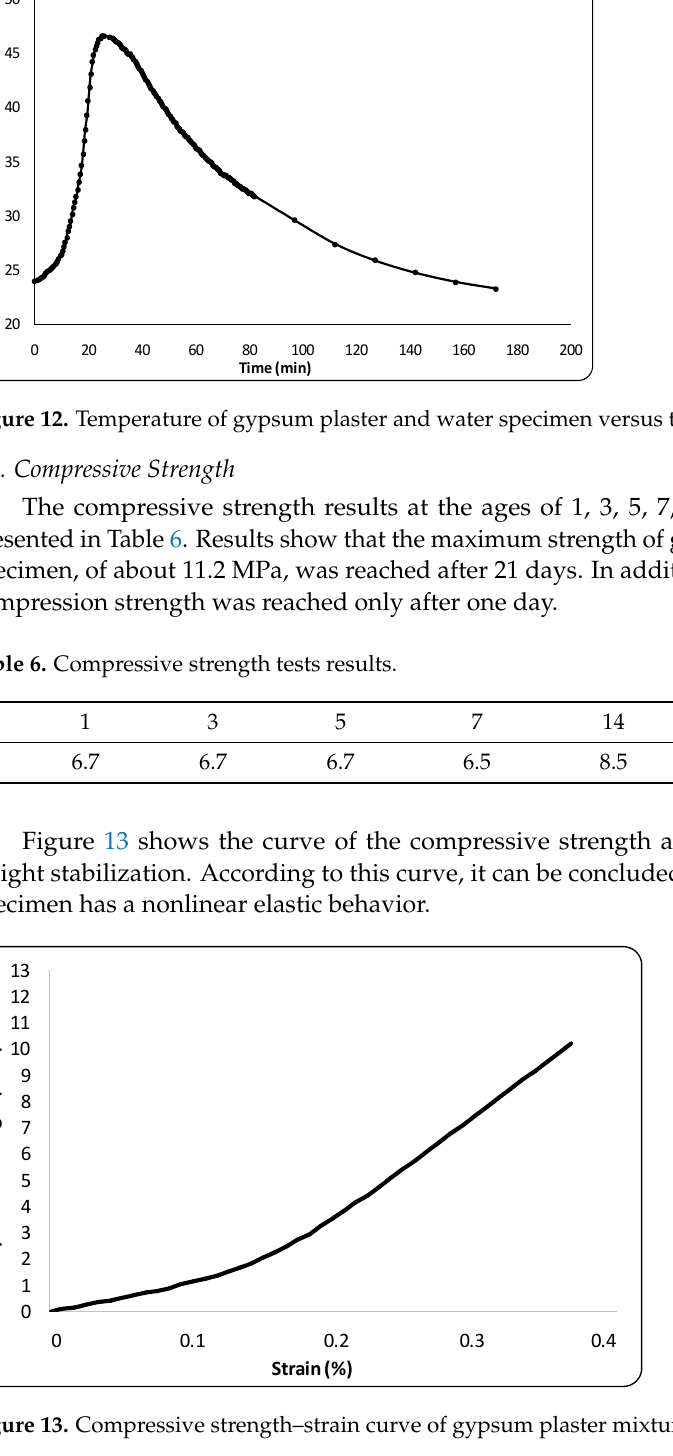
Figure 13. Compressive strength–strain curve of gypsum plaster mixture after weight stabilization.